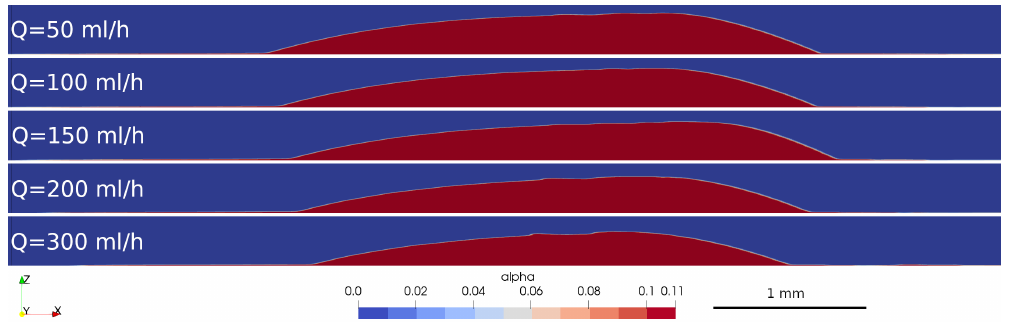
Figure 11. The simulated aggregate shapes at the different flow rates. As the flow rate is increasing, less MNPs are able to aggregate over the magnet. Table 4. The simulated gap heights over the aggregate at different flow